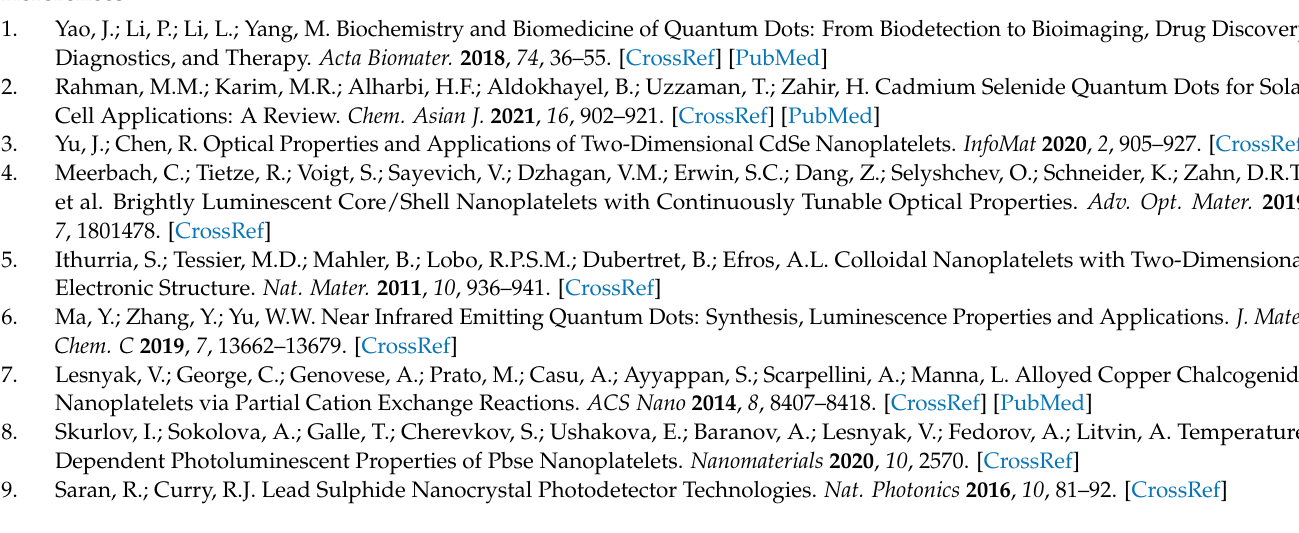
nanoplatelets. Determination of the Pb/Hg molar ratio used during doping procedure of HgTe NPLs. Figure S1. Photoluminescence and absorption spectra of CdTe and HgTe nanoplatelets; SEM image of the initial CdTe NPLs; TEM image of the HgTe NPLs. Figure S2. TEM images of HgTe:Pb NPLs with 1%–5% doping levels. Figure S3. HgTe:Pb NPLs survey XPS spectra. Table S1. HgTe:Pb 1% sample XPS analysis. Table S2. HgTe:Pb 2% sample XPS analysis. Table S3. HgTe:Pb 4% sample XPS analysis. Photoluminescence decay measurement and analysis. Figure S4. Typical HgPbTe (5 min reaction time) NPLs decay curve (red) taken at 830 nm and its 3-exponential fitting (blue) with IRF (black) and residuals (green). Figure S5. PL decay parameters for HgPbTe NPLs vs. Pb exchange reaction time. Figure S6. PL decay curves for NIR PL band of HgTe:Pb nanoplatelets. Figure S7. The n-channel transfer curves of a HgTe:Pb-EDT film samples. References [5,15,33] are also cited in the supplementary